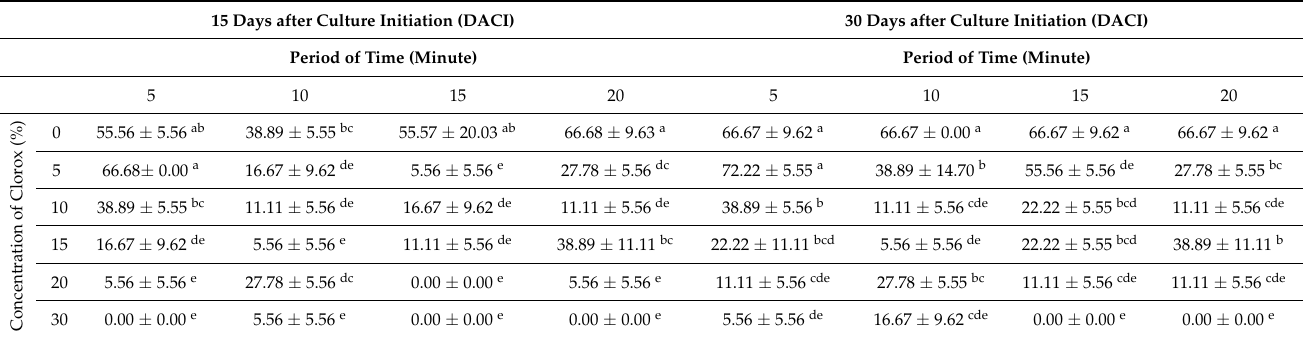
Table 6. Effect of different concentrations of Clorox used as a surface sterilizing agent for different periods of time on fungal contamination on explants (%) of